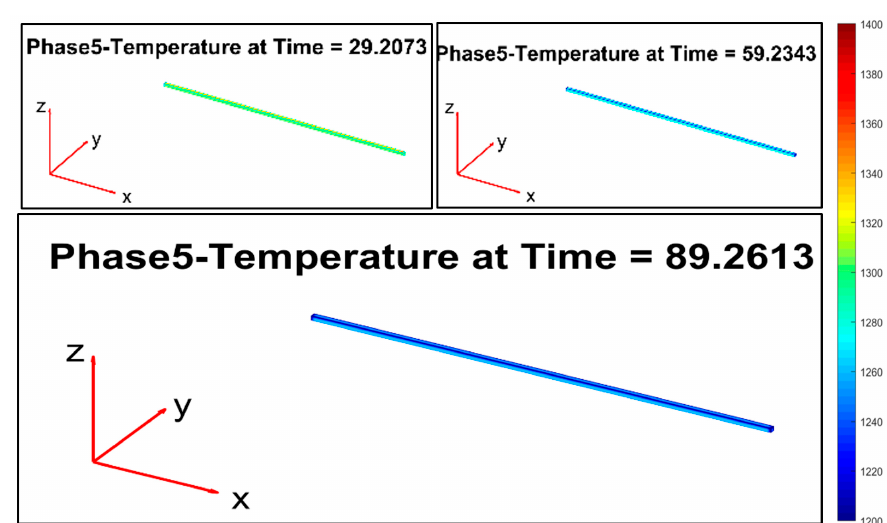
Figure 17. Modelization: phase 5 (movement between stand 2 and stand 3).